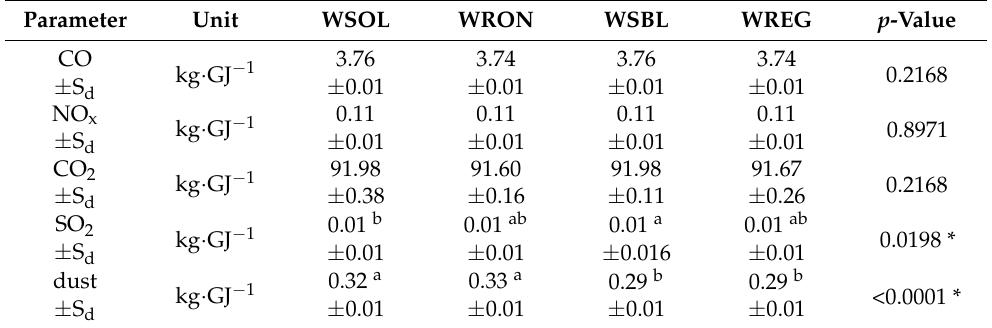
Table 6 summarizes the estimated emission indexes in energy units. Table 6. Emission factors for waste shoots of selected grapevine varieties per unit of energy. Parameter Unit